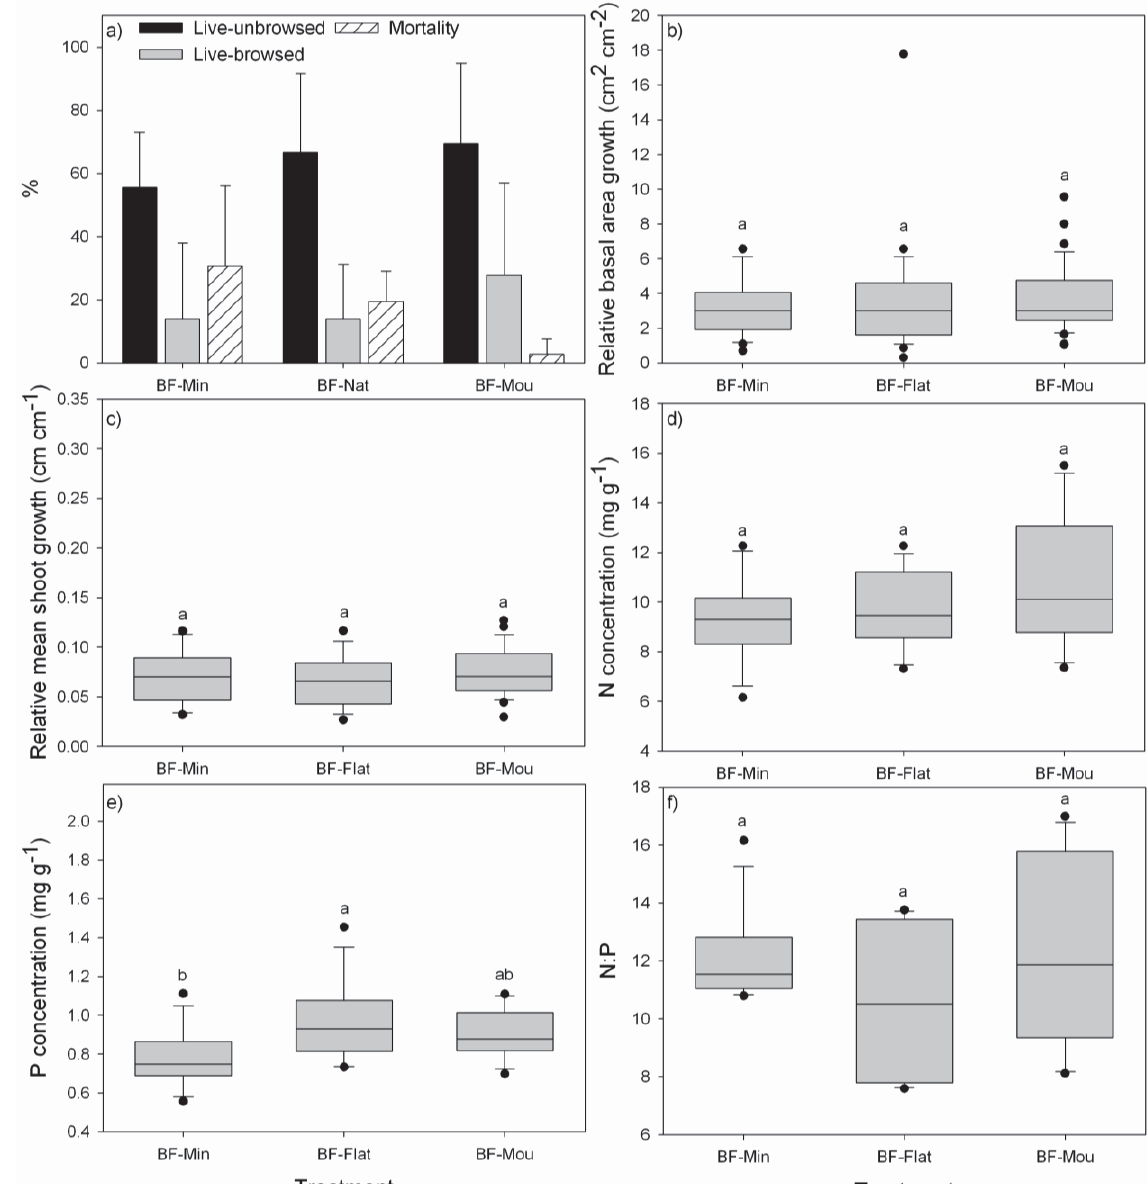
Figure 3. Effect of microtopography on the performance of Pilgerodendron uviferum seedlings growing in bogs on different rooting substrates: ( a ) mortality and survival (%) (living seedlings were divided in “live - unbrowsed” and “live - browsed”) ; ( b ) relative basal area growth (cm 2 cm − 2 ); ( c ) relative mean shoot growth (cm cm − 1 ); ( d ) foliar N concentrations (mg·g − 1 ); ( e ) foliar P concentrations (mg·g − 1 ); and ( f ) foliar N/P ratios (%). Treatments: BF-Min: mineral soil below the original surface after removal of moss; BF-Flat: undisturbed flat Sphagnum layer; BF-Mound: elevated mound, raised through the addition of moss. No significant differences between treatments for the same variable in (a). Treatments with different lowercase letters were significantly different ( p ≤